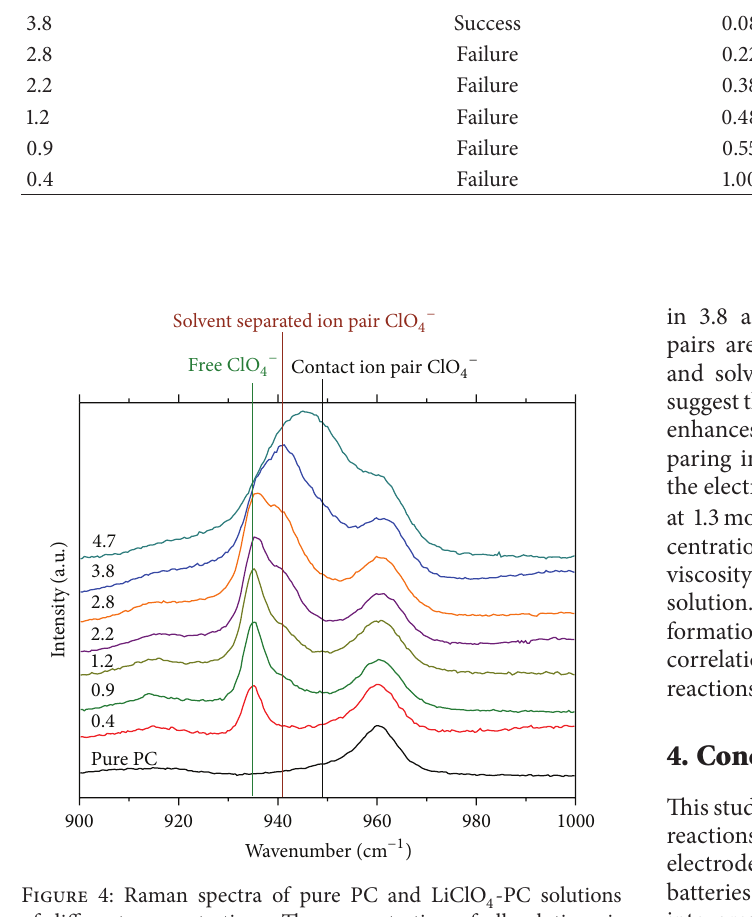
Table 2: Mole fraction of ClO Concentration (moldm − 3 )